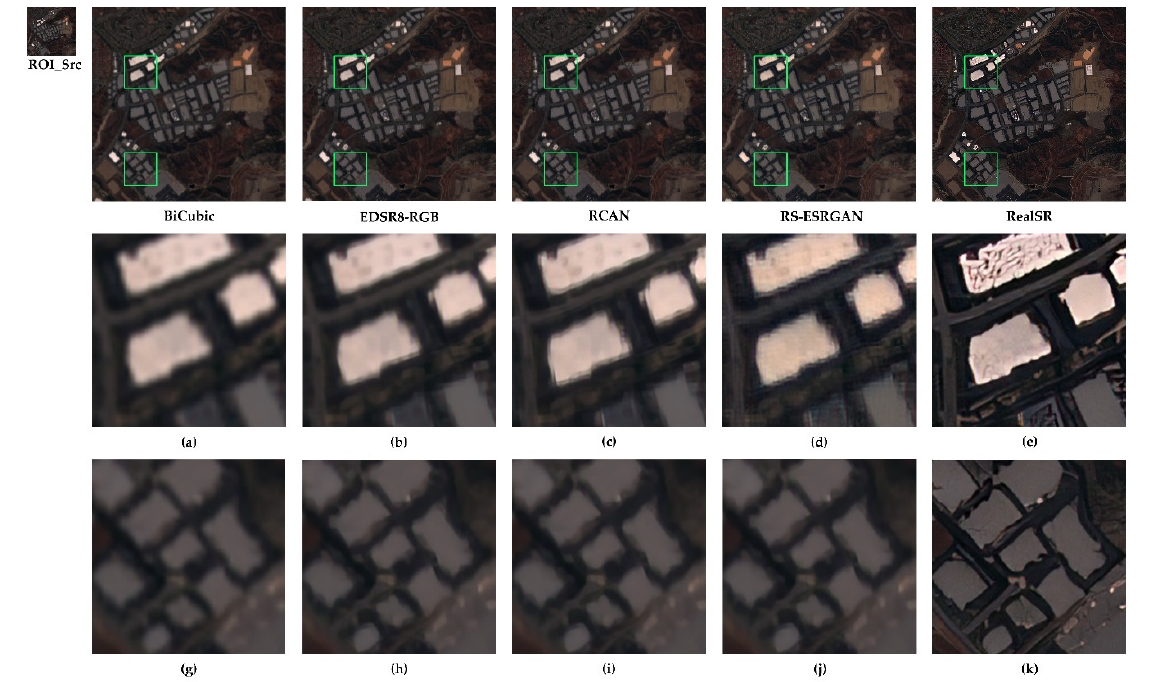
Figure 17. Comparison of visual effects of the generated images of the region containing dry riv- erbeds and residential houses. NR-IQA of images (NIQE, BRISQUE, PIQE): BiCubic (6.30, 50.23, 100.00), EDSR8-RGB (5.17, 49.48, 73.97), RCAN (4.30, 46.78, 58.43), RS-ESRGAN (3.06, 23.08, 18.75), RealSR (3.23, 12.43, 9.51), TS-SRGAN (2.70, 28.73, 11.47). The subfigures ( a – l ) in the figure represent an enlarged view of the local details in the green boxes in the generated image.